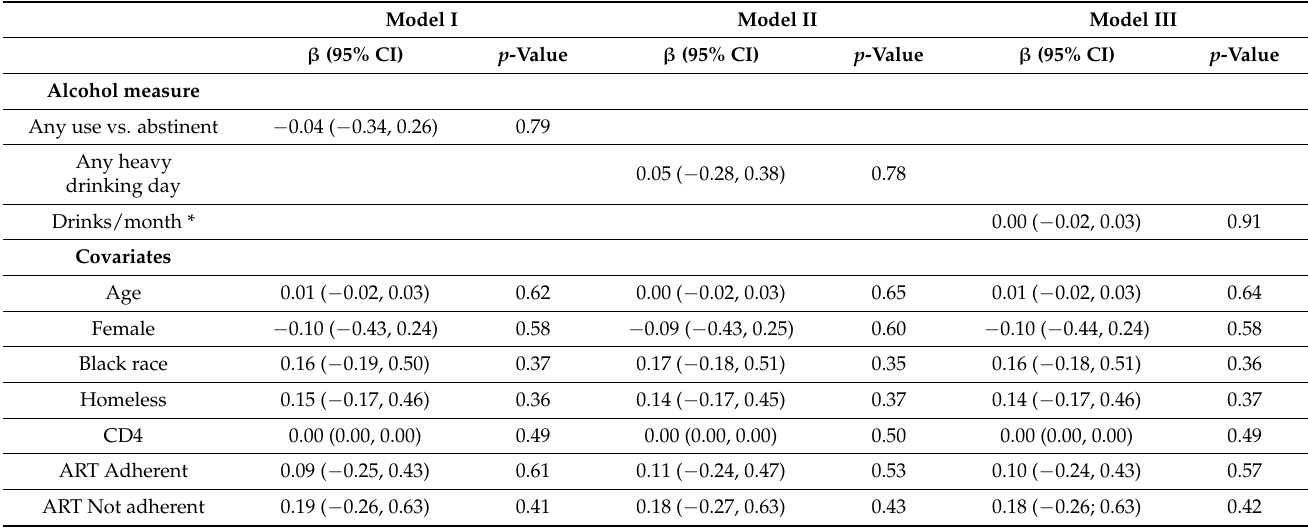
Table 2. Multivariable analysis of the association between alcohol use and log HCV RNA in a cohort of HIV and HCV coinfected persons with current or past unhealthy alcohol